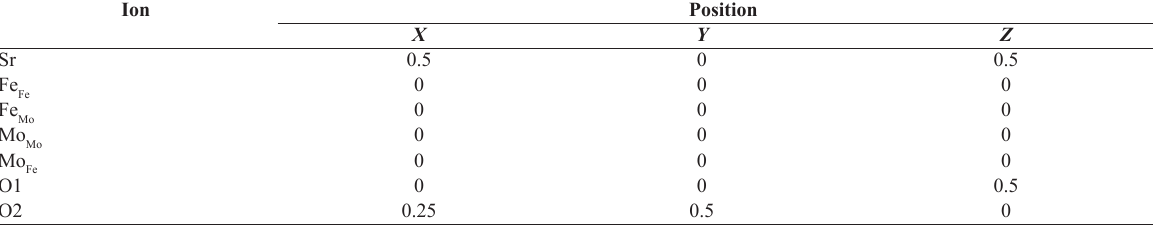
Table 1. Ion positions in the SFMO lattice